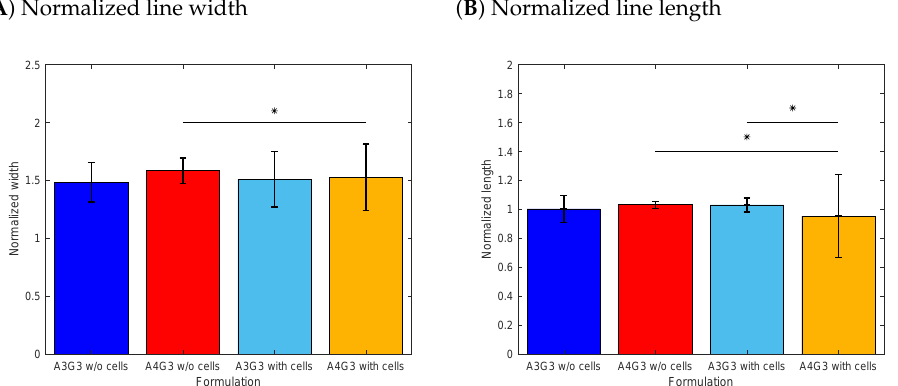
Figure 4. Printing accuracy study line structure. In ( A ), the normalized line width is shown, and in ( B ), the normalized line length. For all four formulations, three biological replicates ( n = 3) were produced, and eight technical replicates ( n = 8) printed for each structure, resulting in a total of 24 objects, of which the mean is shown in a bar with the associated standard deviation. Significant differences are denoted with an asterisk ( p <